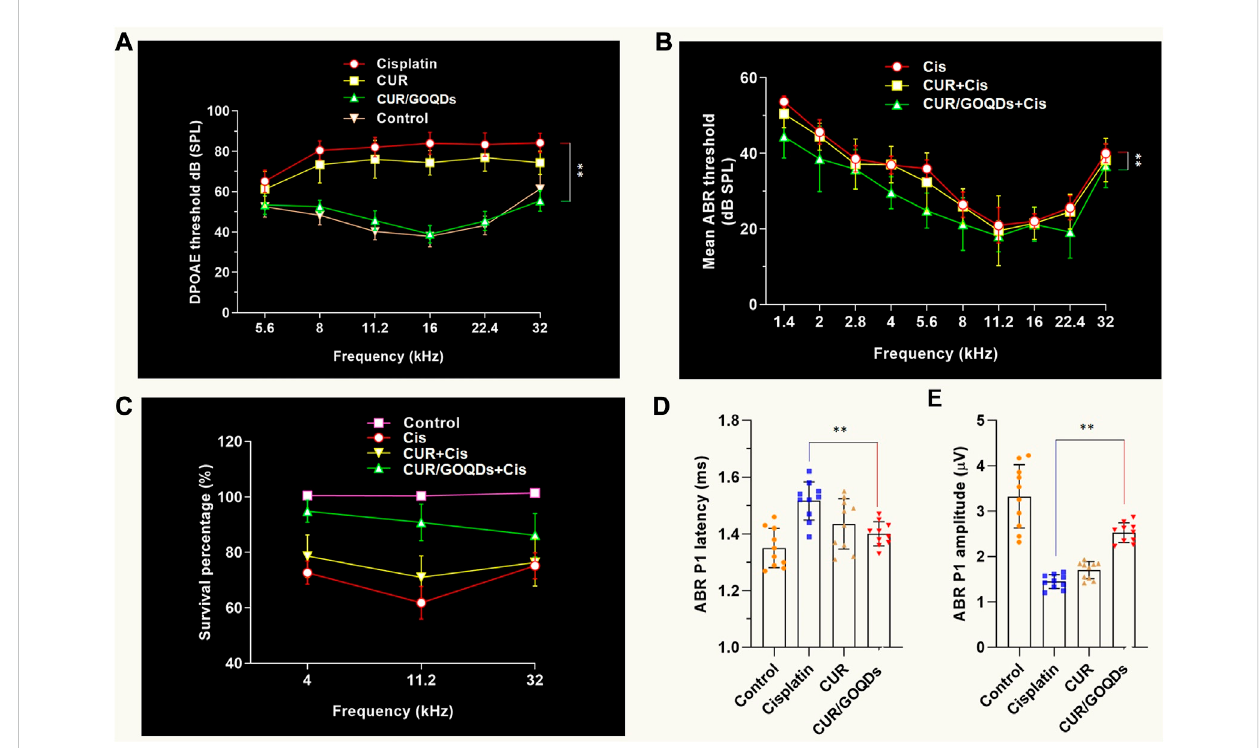
FIGURE 7 CUR/GOQDs partially rescue CIS-induced hearing loss. (A – C) High concentration of CIS causes severe hearing loss inguinea pigs. Guinea pigs treated with CIS of different concentrations for 2 weeks were tested according to DPOAE and ABR. Mean ABR threshold of guinea pigs treated with CIS, CUR or CUR/GOQDs. (A) DPOAE threshold and ABR threshold, (B) ABR peak 1 (P1) latency, (C) ABR peak 1 (P1) amplitude. (D – E) The DPOAE and ABR thresholds were signi fi cantly higher in the high-dose (80 mg/kg) CIS treated group than in the untreated group; n =